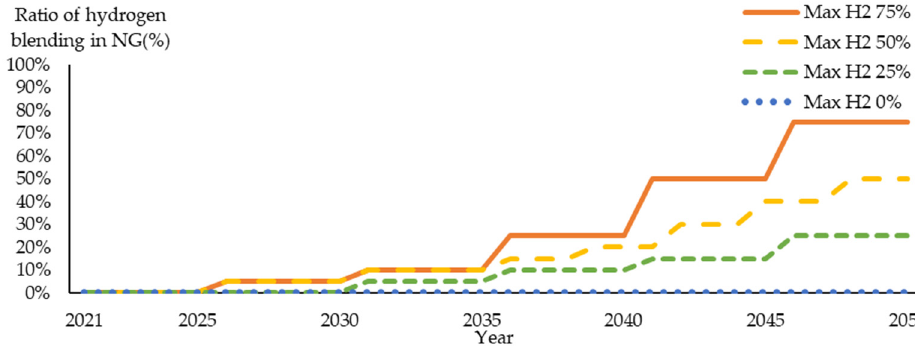
Figure 11. Percentage of hydrogen blended into the natural gas network.